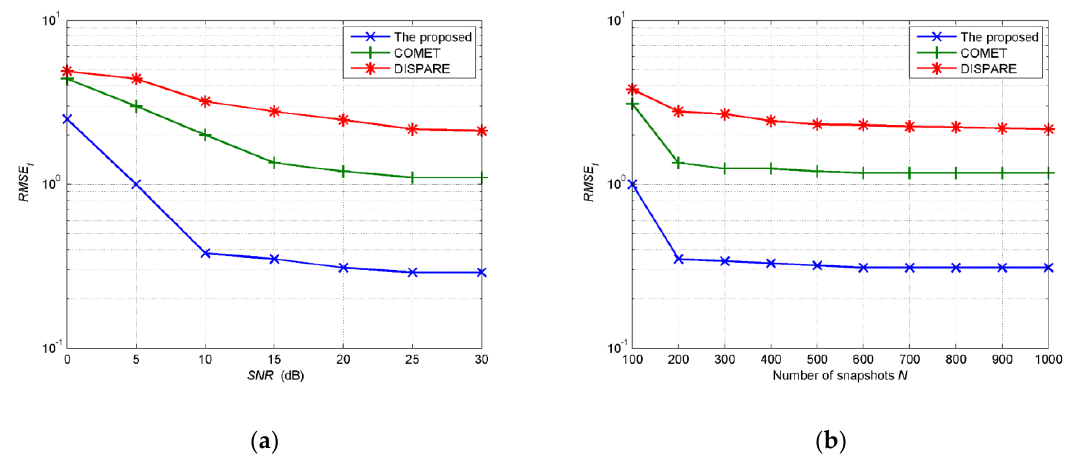
Figure 7. ( a ) RMSE f estimated by the three methods versus SNR; ( b ) RMSE f estimated by the three methods versus number of snapshots.